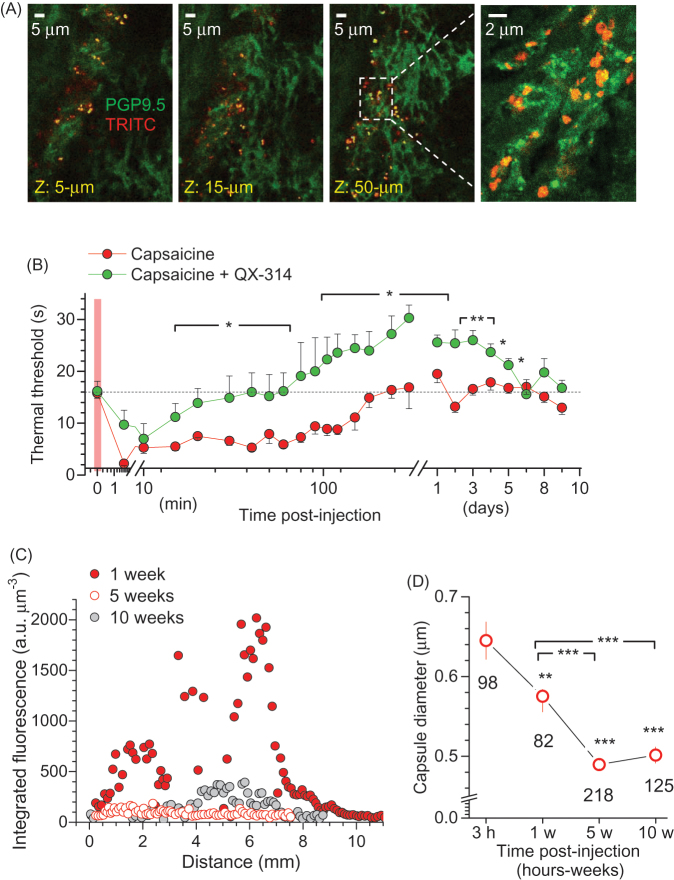
Microcapsules co-localize with peripheral nerve fibers, engage TRPV1-mediated analgesic effect of QX-314, and degrade with a time. (A) Examples of immunohistology of glabrous skin tissue (individual focal planes shown) for microcapsules carrying encapsulated QX-314 (3 mM; TRITC fluorescence, red) surrounding peripheral nerve fibers (neuron-specific PGP9.5 staining, green). Transverse skin sections (30 µm thick). (B) Time course of the thermal pain threshold in animals injected with capsaicin (1.5 µg µl−1, n = 6 rats) or with capsaicin together with 7.4 mM QX-314 (non-capsulated, n = 6). Data are mean ± SEM. *p < .05, **p < .01 (one-way ANOVA with Bonferroni post hoc test). (C) The z-axis profile of the microcapsule fluorescence (TRITC, λx2P = 820 nm; 3 mM encapsulated QX-314, integrated fluorescence) inside the skin tissue from the rat hind paw at different times post-injection in vivo, as indicated. Total scanned volume ∼370 µm3; 3 µm z-steps. (D) Averaged diameter of microcapsules inside the skin tissue from the rat hind paw at different time points post-injection in vivo, as indicated. The reduced diameter reflects progressive degradation of the outer capsule shell. Total number of analyzed capsules is indicated; **p < .01, ***p < .001 (one-way ANOVA with Fisher’s test).